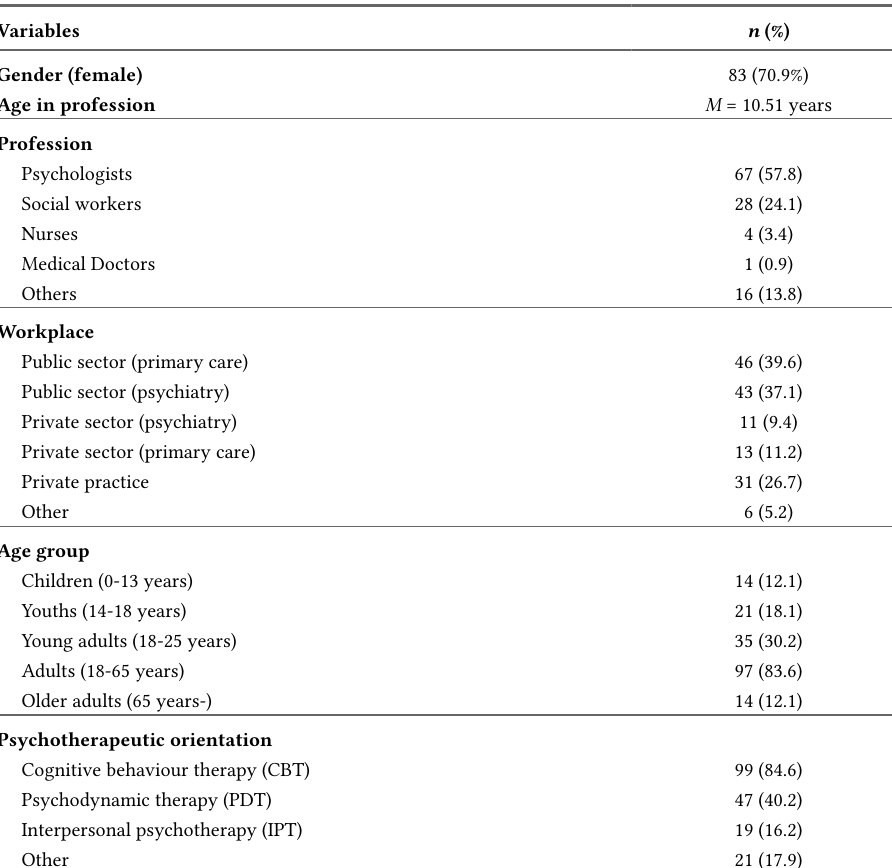
Background Data of the Participating Psychotherapists (N =